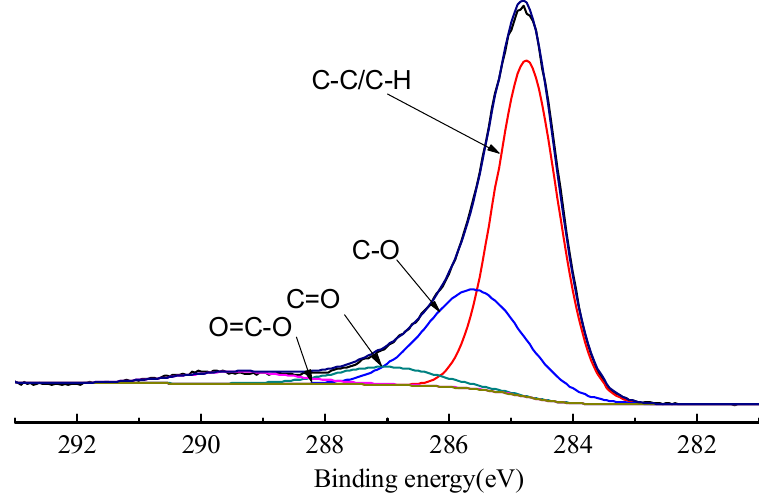
Figure 3. The C1s fitting spectra of coal sample.